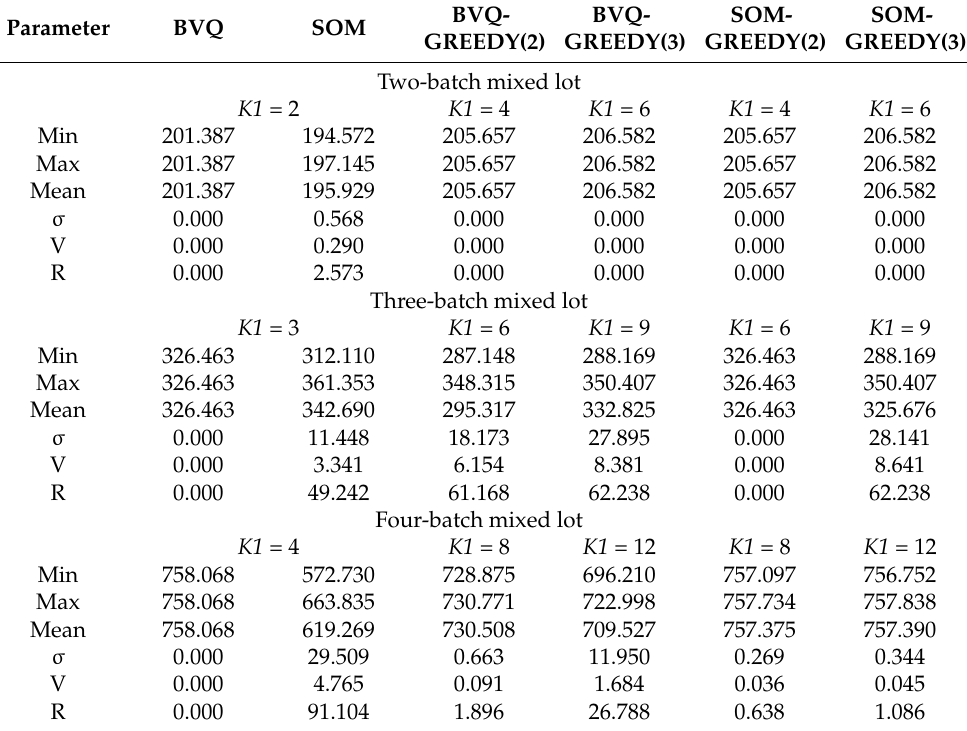
Table A10. Objective function value summarized after 30 attempts (Mahalanobis distance, initializa- tion by